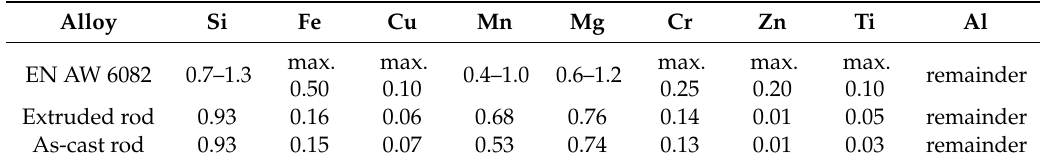
Table 1. Chemical composition of experimental material in wt.